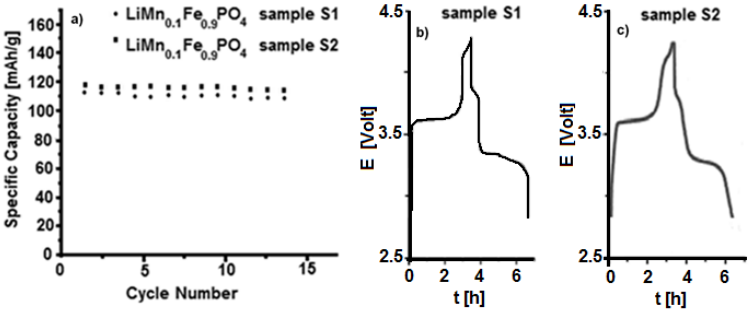
Figure 7. ( a ) Electrochemical galvanostatic tests at C/5 rate for samples S1 and S2 ; and ( b ) voltage profile of sample S1 ; ( c ) voltage profile of Sample S2 .